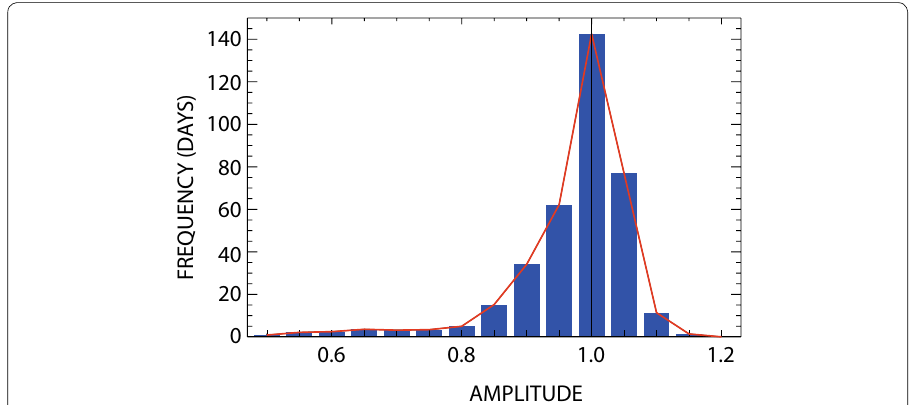
Fig. 5 Histogram of the first PC time series of the boarding passengers. The histogram is highly skewed with a long tail toward the low